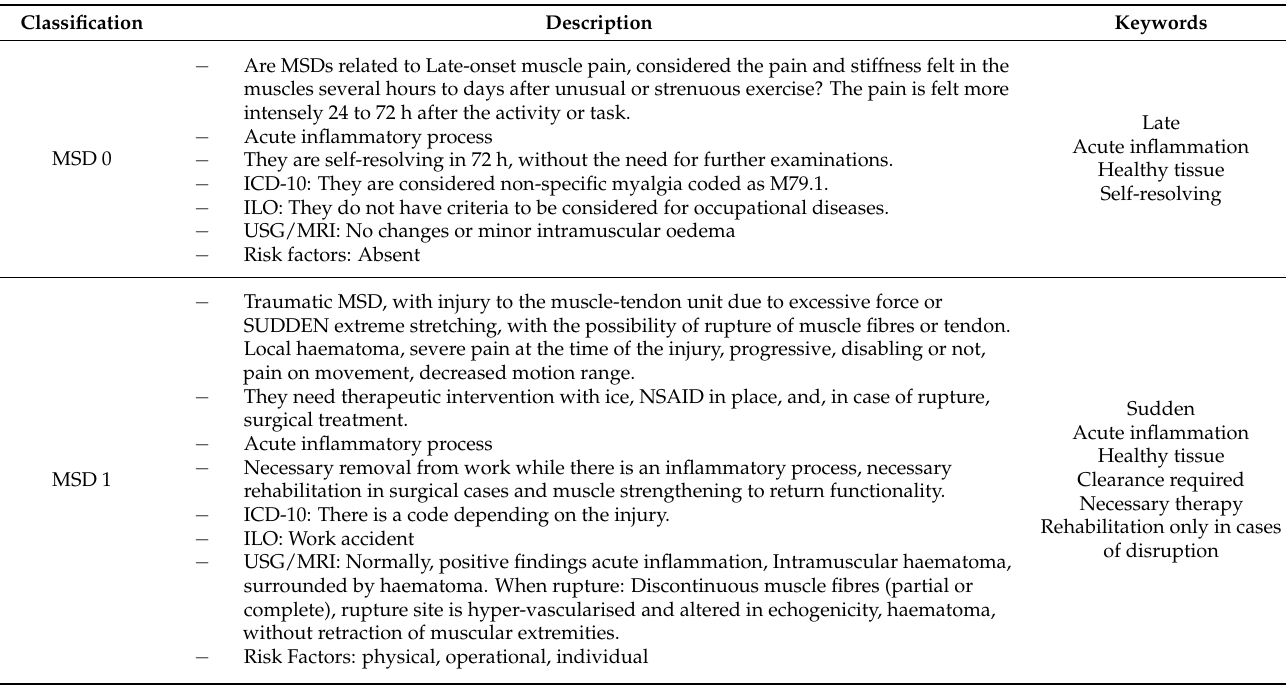
Table 6. Classification process